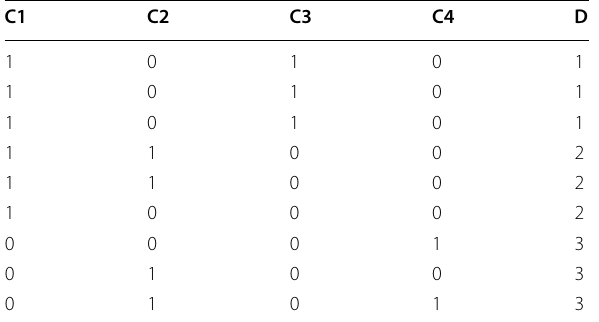
Table 1 Initial decision table for the simulation experiment